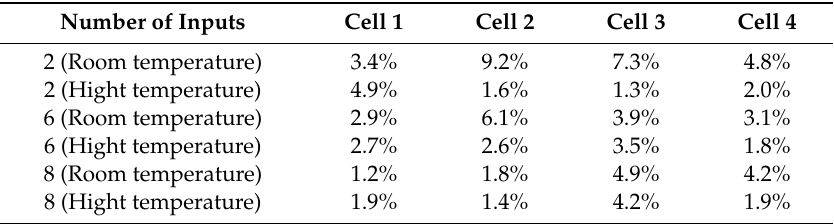
Table 3. Results of SOC estimation using the LSTM according to the di ff erence in the number of